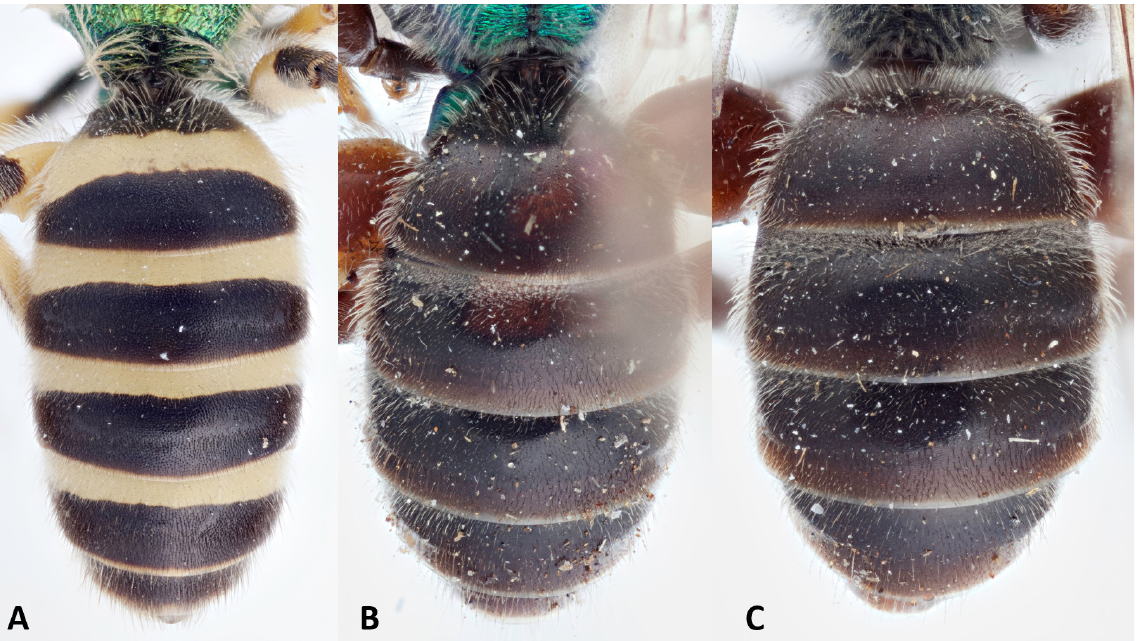
Fig. 9. Dorsal view of the metosoma of male. A . Agapostemon virescens (Fabricius, 1775). B . Ag. femoralis (Guérin-Méneville, 1844). C . Ag. obscuratus Cresson, 1869 [= Ag. femoralis ].